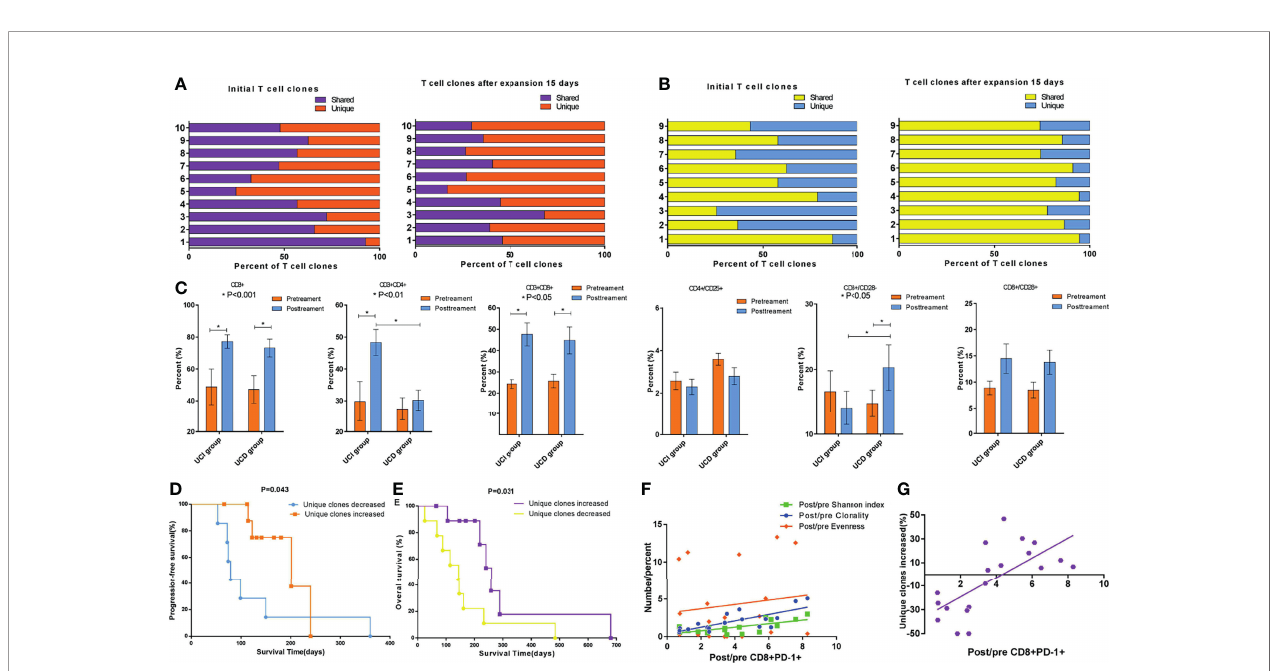
FIGURE 5 | Changes inTCRsubclones during exvivo T-cellexpansionandtheassociationofCD8 + PD-1 + T cells withTCR diversityandsubclones. (A) TheuniqueTCRclones increasedandthe sharedTCR clonesdecreasedafter T-cellexpansion exvivo in10patients(p<0.05). (B) TheuniqueTCRclones decreasedandthesharedTCRclones increasedafter T-cellexpansion exvivo in9 patients. (C) PeripheralbloodT-cellphenotypemeasurements via cytometrybefore andafterthe fi rstcycleofACTcelltherapydivided byalterationofuniqueTCRclones. (D,E) SurvivalanalysisshowedthatthegroupwithincreaseduniqueTCRcloneshadsigni fi cantlylonger PFS (p= 0.043) andOS(p= 0.031). (F) Correlationanalysisshowedthatthepost-/pre-CD8 + PD-1 + Tcellsweresigni fi cantlyassociatedwiththepost-/pre-Shannonindex(r 2 =0.484,p=0.009) andClonality(r 2 = 0.579, p= 0.002), butnotEvenness (r 2 =0.018,p= 0.575). (G) Thepost-/pre-CD8 + PD-1 + Tcellswere signi fi cantlyassociatedwiththeuniqueTCR repertoire clonesinpatients who receivedACT (r 2 =0.464,p=0.001). TCR,T-cellreceptor; ACT,adoptiveT-celltherapy; PFS, progression-free